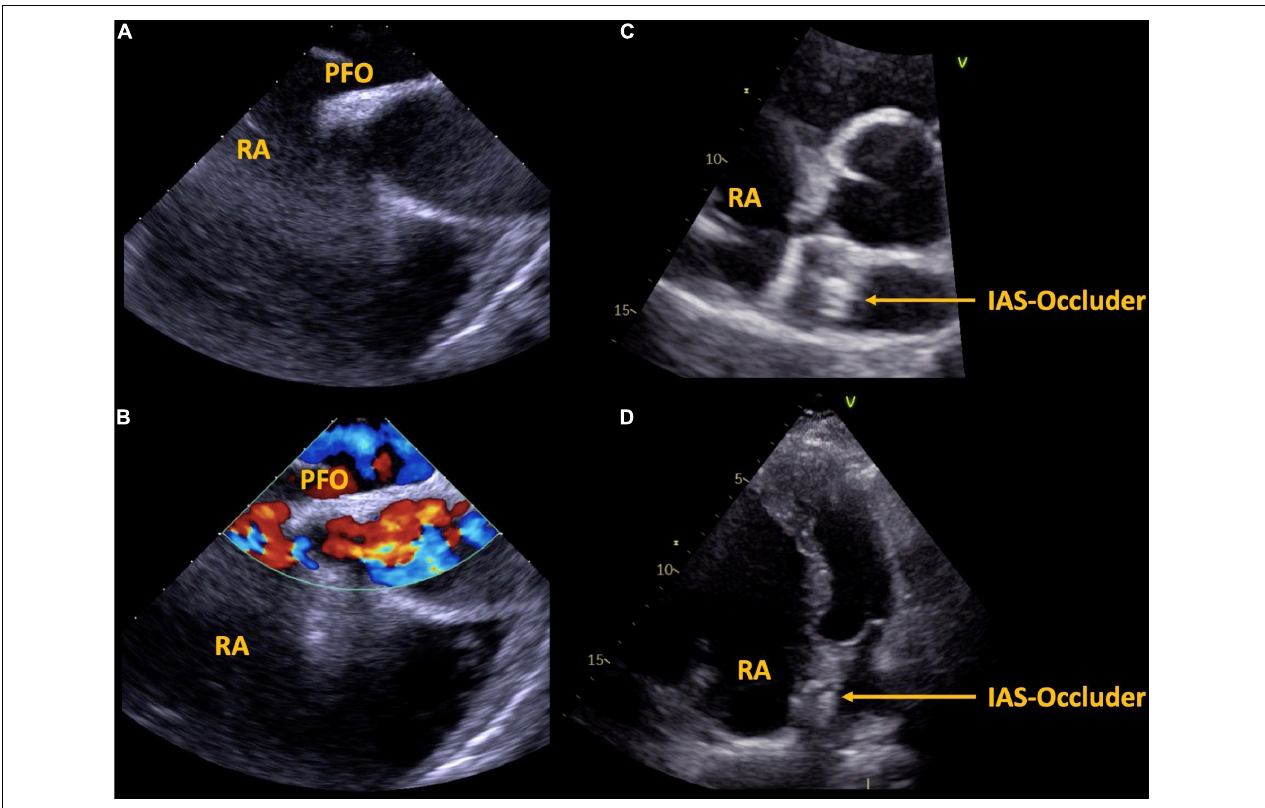
FIGURE 3 | Case 2, 57 year-old patient with Ebstein’s anomaly. A large PFO is shown via transesophageal echocardiography without (A) and with (B) color Doppler imaging. Interventional septal occluder implantation was performed, the result is shown in panels (C,D) . PFO, patent foramen ovale, IAS, inter atrial septum, RA, right